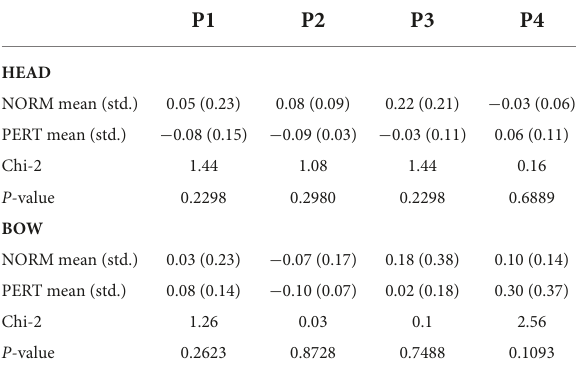
TABLE 5 Correlation coefficients representing the co-evolution of V1’s and V2’s head (upper table) and V1’s head and V2’s bow (lower table) power spectral density at the four frequency bins that corresponded to the piece metrical levels (P1 – P4), compared across experimental conditions. P1 P2 P3 P4 HEAD NORM mean (std.) PERT mean